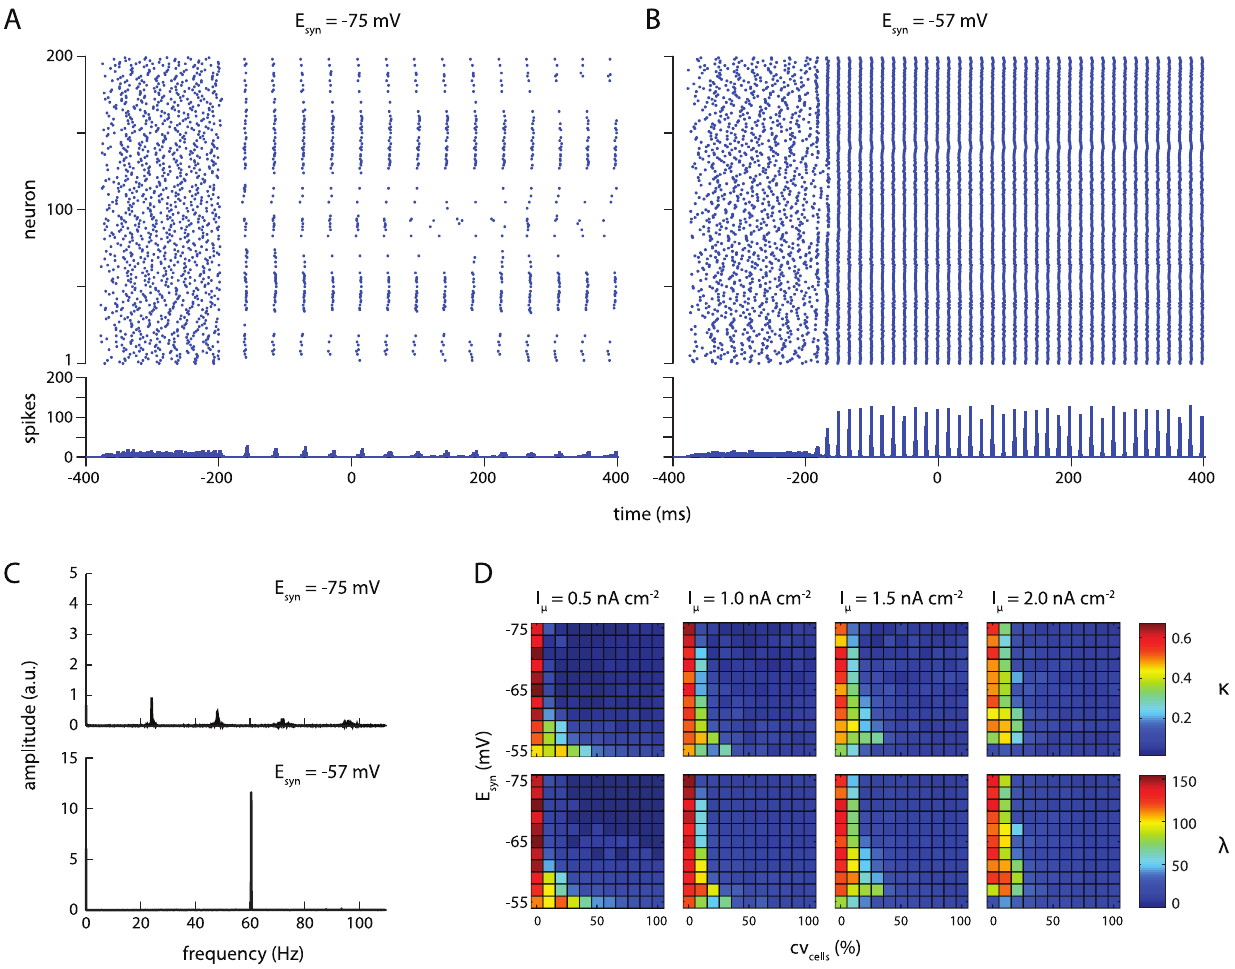
Figure 2. Shunting inhibition increases robustness in a network of fast-spiking inhibitory interneurons. (A–B) Rasterplots (top) and spike histograms (bottom) for simulations GABA -synaptic reversal potentials of { 75mV (A) and { 57mV (B). For these plots, mean drive I m ~ 0 : 5nA cm { 2 , drive variation CV cells ~ 10% . Synapses were activated at t ~{ 200ms ; plots are truncated at t ~ 400ms . (C) Amplitude spectra for spike histograms. Spectral analyses were performed on complete histograms, ending at t ~ t stop ~ 2047ms . (D) Two measures of network synchronization, network coherence k (top row) and average spike volley peak height l (bottom row), as a function of drive variation over cells CV cells (x-axis), synaptic reversal potential E syn (y-axis), and mean drive I m (separate columns). Shunting values of E syn result in stronger synchronization with increasing drive heterogeneity.